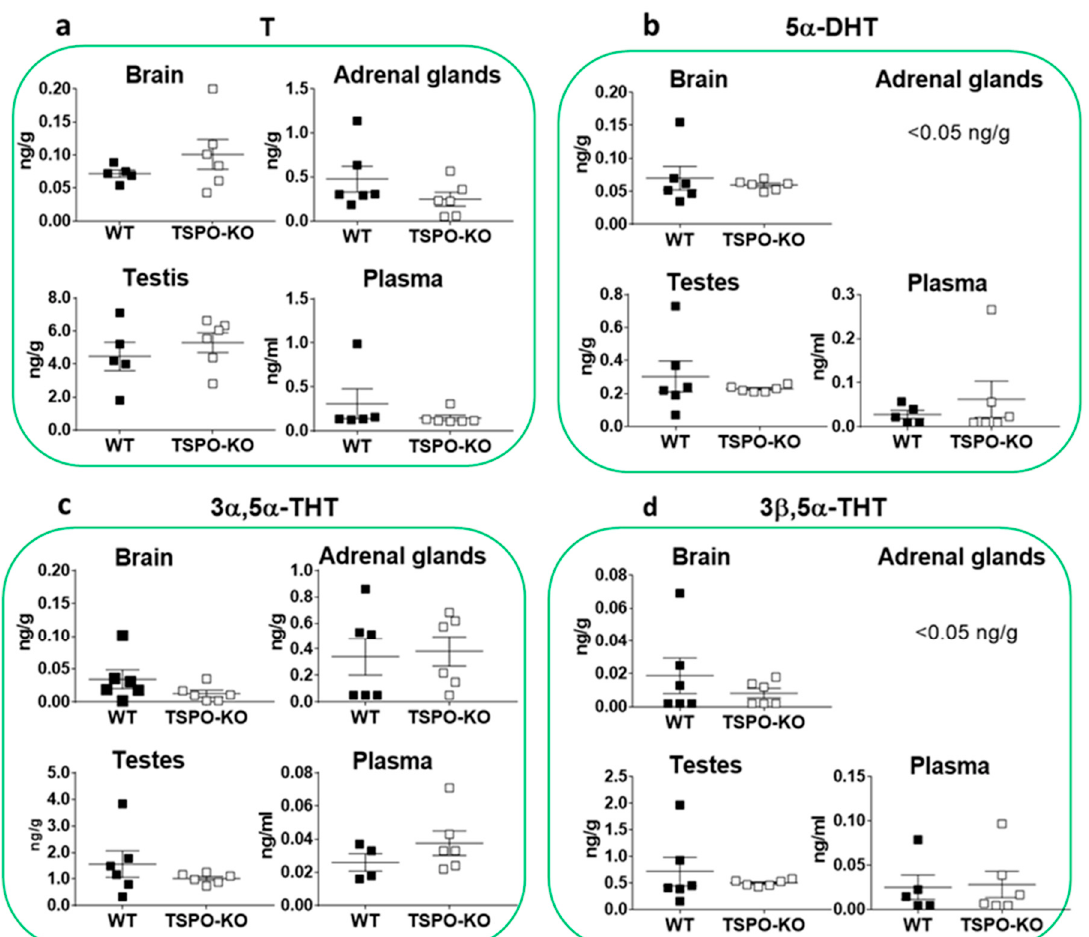
Figure 6. Concentrations of testosterone (T) and its 5 α -reduced metabolites in tissues of male WT and TSPO-KO mice analyzed by GC-MS/MS as described in the Material and Methods section. Data are expressed as means ± SEM and were analyzed by unpaired t -test ( n = 5–6).